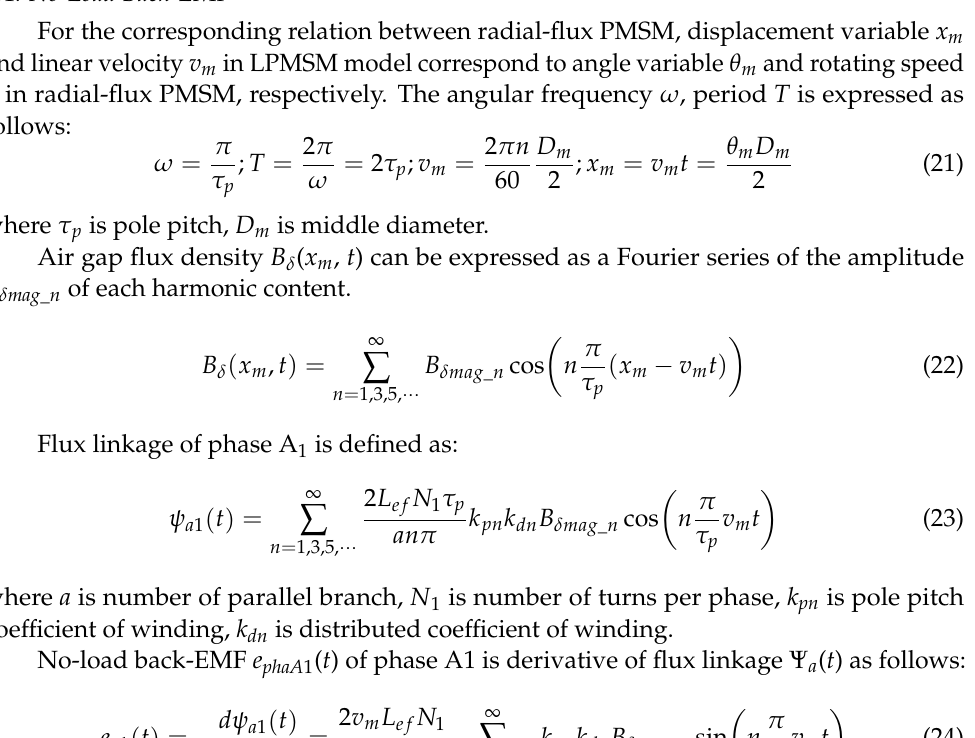
14 of 21 Figure 19. Air gap flux density ( a ) changing with slotting opening width b 01 , ( b ) FFT, ( c ) changing with space and time. In order to validate the analytical result of air gap flux density, a probe of Teslameter